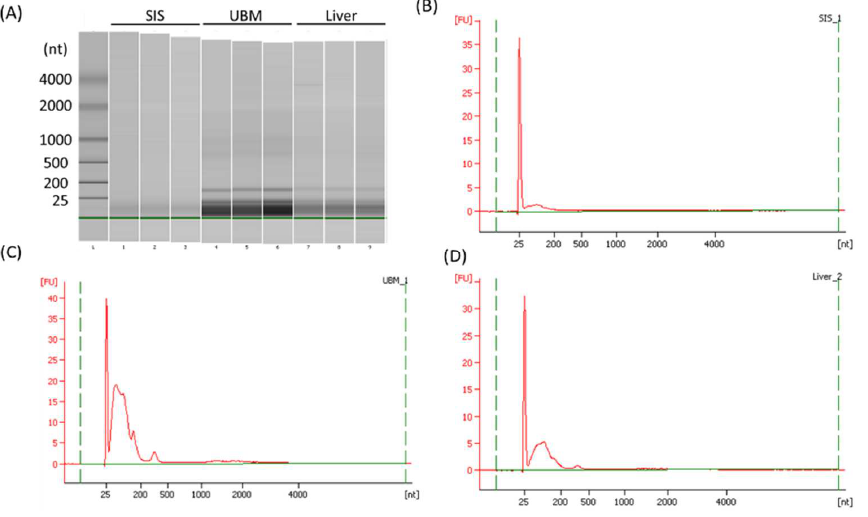
Figure 6. Bioanalyzer gel image ( A ) and electropherograms of total RNA isolated from MBVs de- rived from HHP-decellularized SIS ( B ), UBM ( C ), and liver ( D ). from HHP-decellularized SIS ( B ), UBM ( C ), and liver ( D